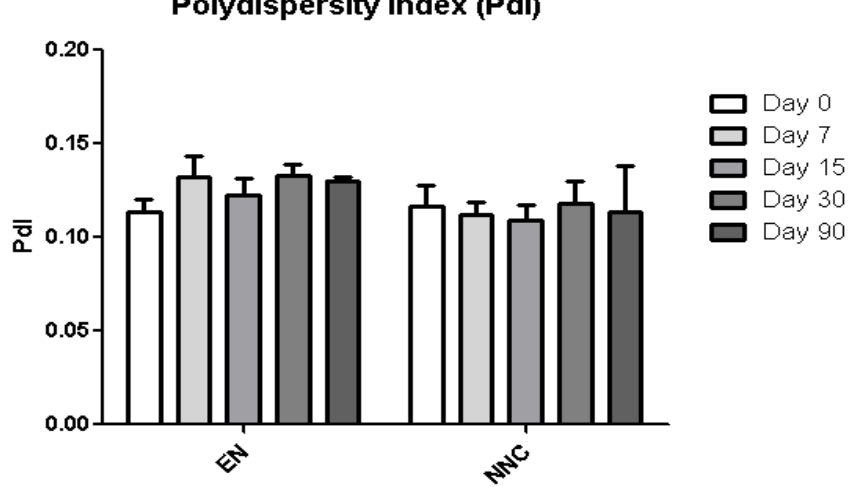
Figure 5. Polydispersity index (PdI) stability of empty nanocapsules (EN) or nicotine containing nanocapsules (NNC) for a period of 90 days of storage. No statistical difference was obtained, signifying that the size distribution of the nanocapsules remained stable throughout the period of analysis ( n = 3).